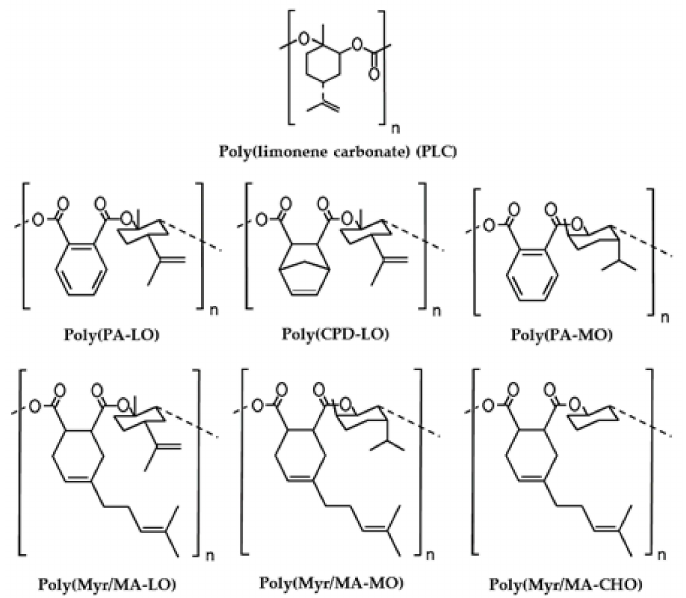
Figure 1. Chemical structure and abbreviations of the different studied terpene derivatives.